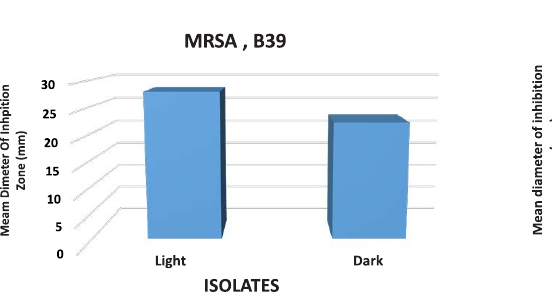
Fig. 2-b. Antimicrobial activity of mixture of ethyl acetate extracts of P. plebeium , ( PP) and E.hirta, (EH) against MRSA B39 in relation to static and shaken